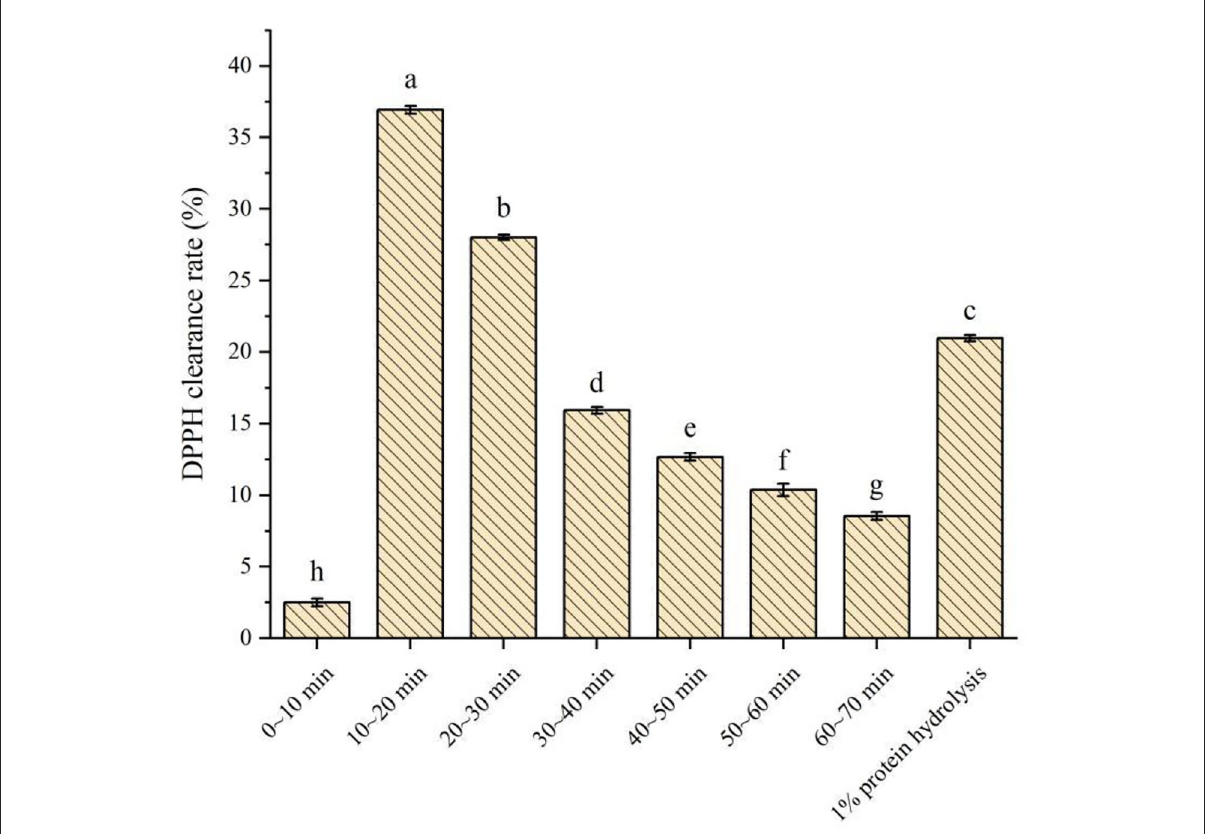
FIGURE6 Determination of antioxidant capacity of purified components of PSKB protein peptide. There is a significant difference between different small letters ( P < 0.05).